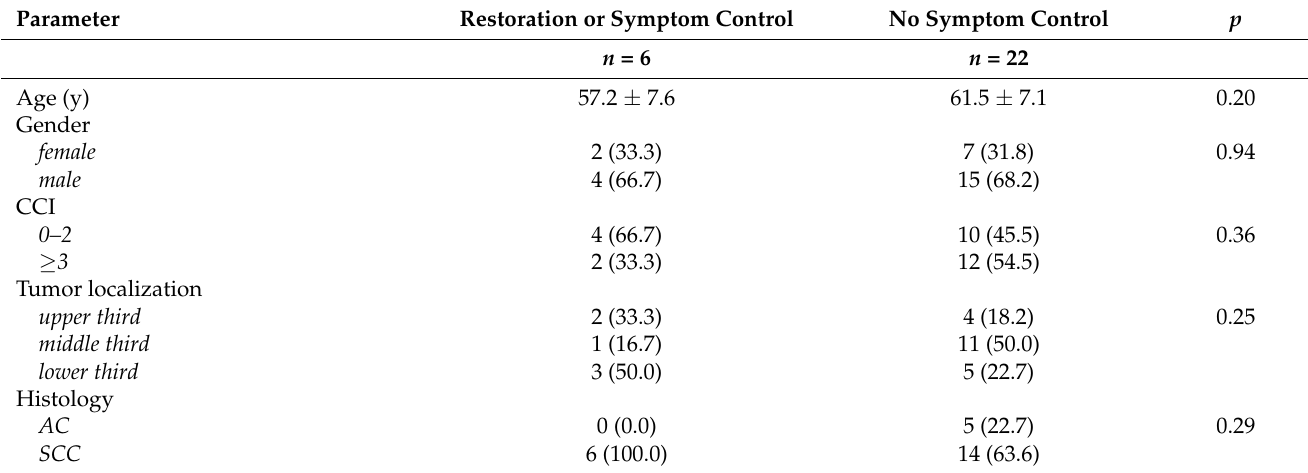
Table 2. Correlation of demographic, clinicopathological, and RDF parameters, and risk factors with clinical outcome in T-RDF